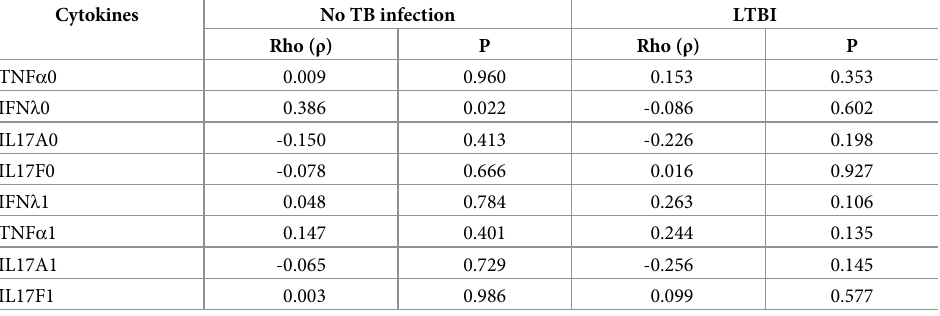
Spearman’s Pair-wise, TNF tumor necrosis factor, IL interleukin, IF interferon P = 0.05 is